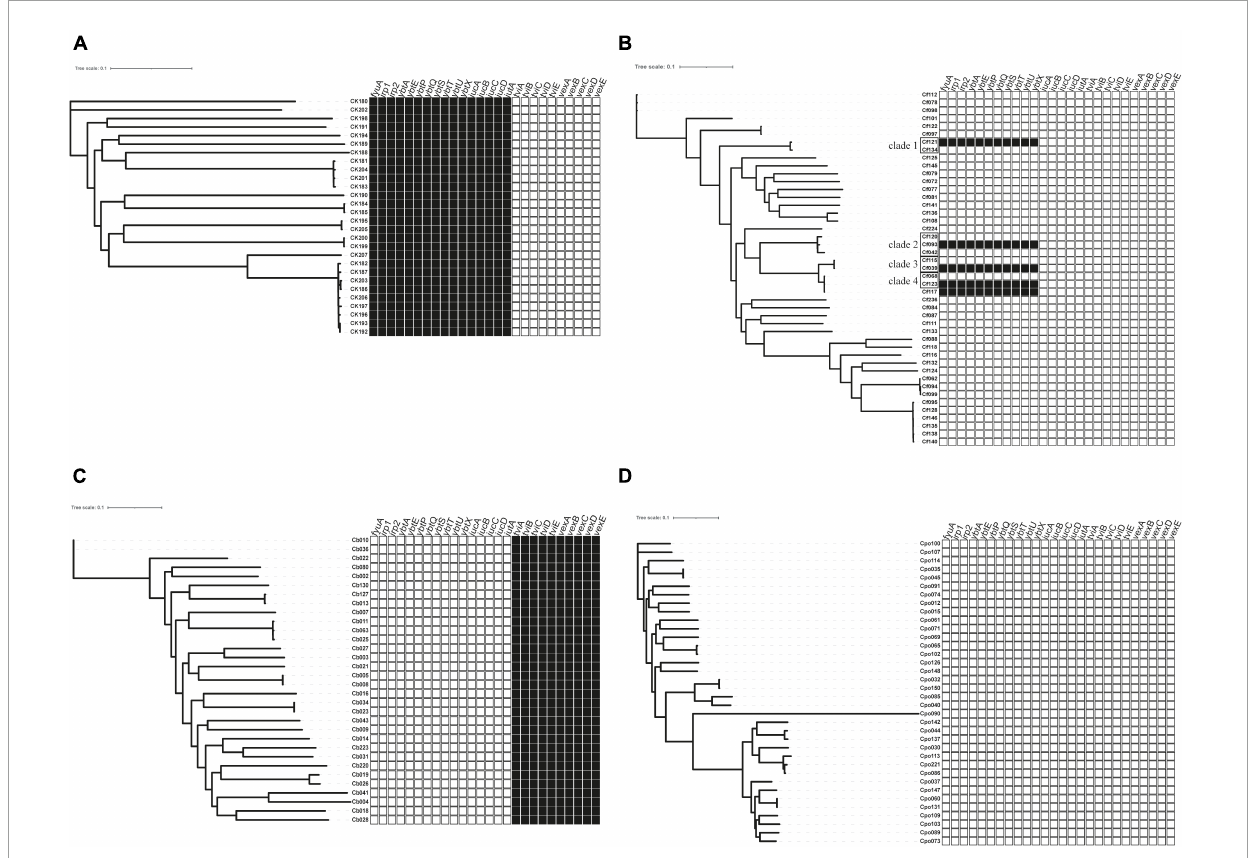
FIGURE2 The distribution of virulence factors across Citrobacter spp. Boxes represent iron uptake and Vi capsule virulence factors derived from whole-genome data comparison with VFDB. (A) C . koseri , (B) C . freundii , (C) C . braakii , and (D) C . portucalensis . , exist; , absence. For a full outline of sources, see Supplementary Table 1